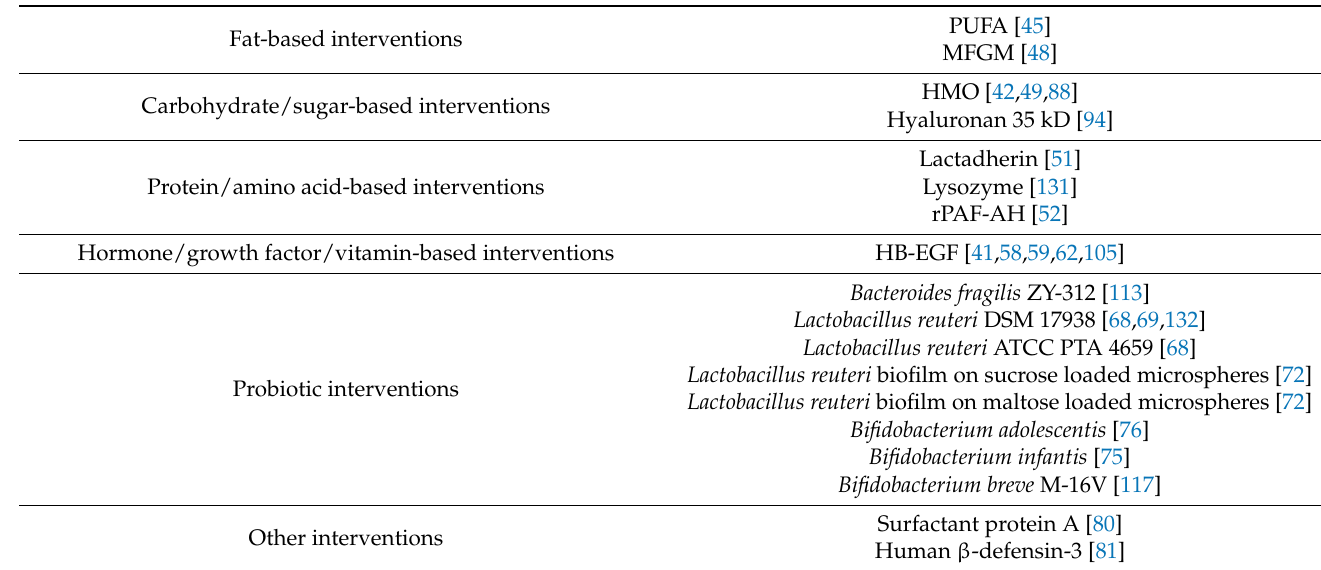
Table 4. Enteral feeding interventions improving survival in experimental animal models of